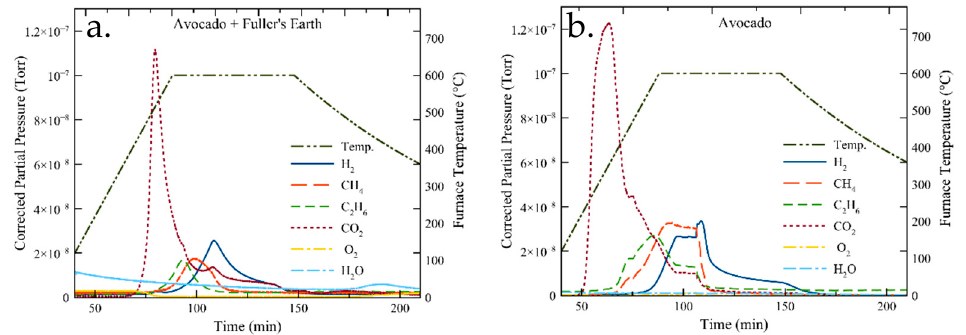
Figure 2. Gas emissions from pyrolysis of ( a ) avocado pits with 20% bentonite clay and ( b ) avocado pits.